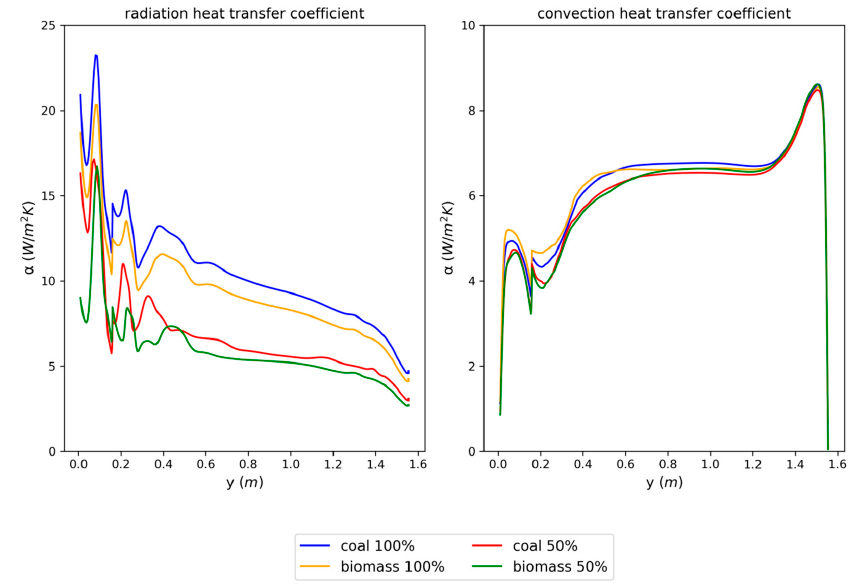
Figure 8. Distribution of radiation and convection heat transfer coefficient obtained on the flue gas side of a chamber wall as a function of combustion chamber height.